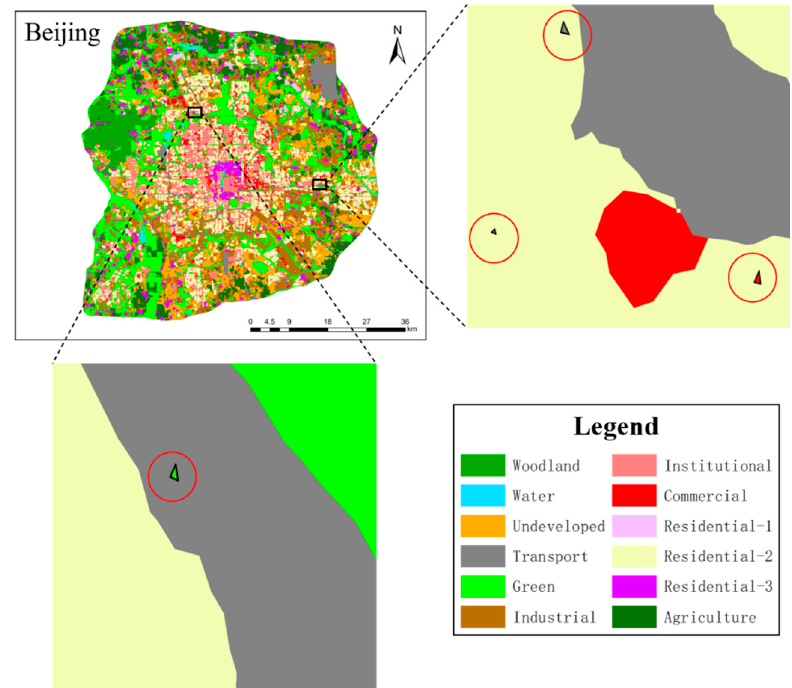
Figure 9. Urban functional zones of no practical significance in Beijing.